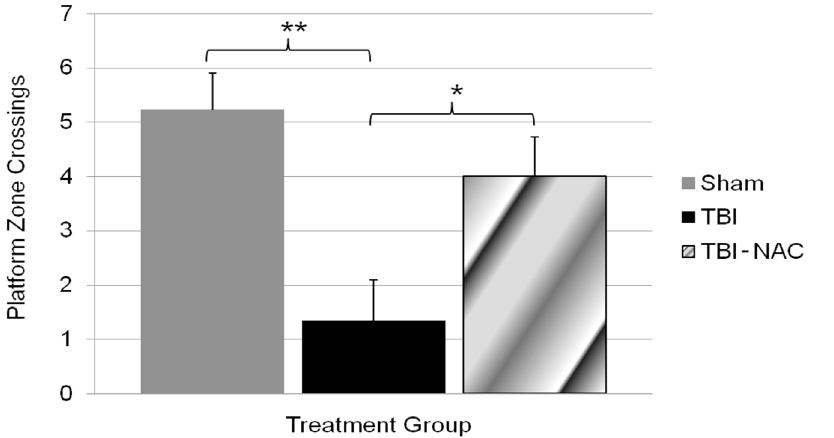
Figure 2. MWM platform crossing. Number of times animals crossed within a 7.5 cm radius of the platform border during the probe trial. A one- way ANOVA showed significant differences between groups. Fisher’s LSD post hoc showed that sham and TBI-NAC had significantly better retention of the platform location as compared to TBI alone. Data are presented as the mean 6 SEM . Brackets indicate comparisons between groups. * p , 0.05, ** p , 0.01.